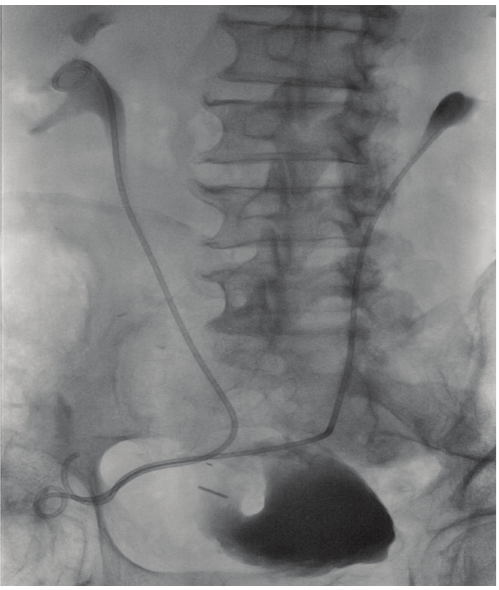
Figure 3: Contrast study after stent placement demonstrating right and left ureteric stents extending from renal pelves, through each ureter and exiting through the conduit